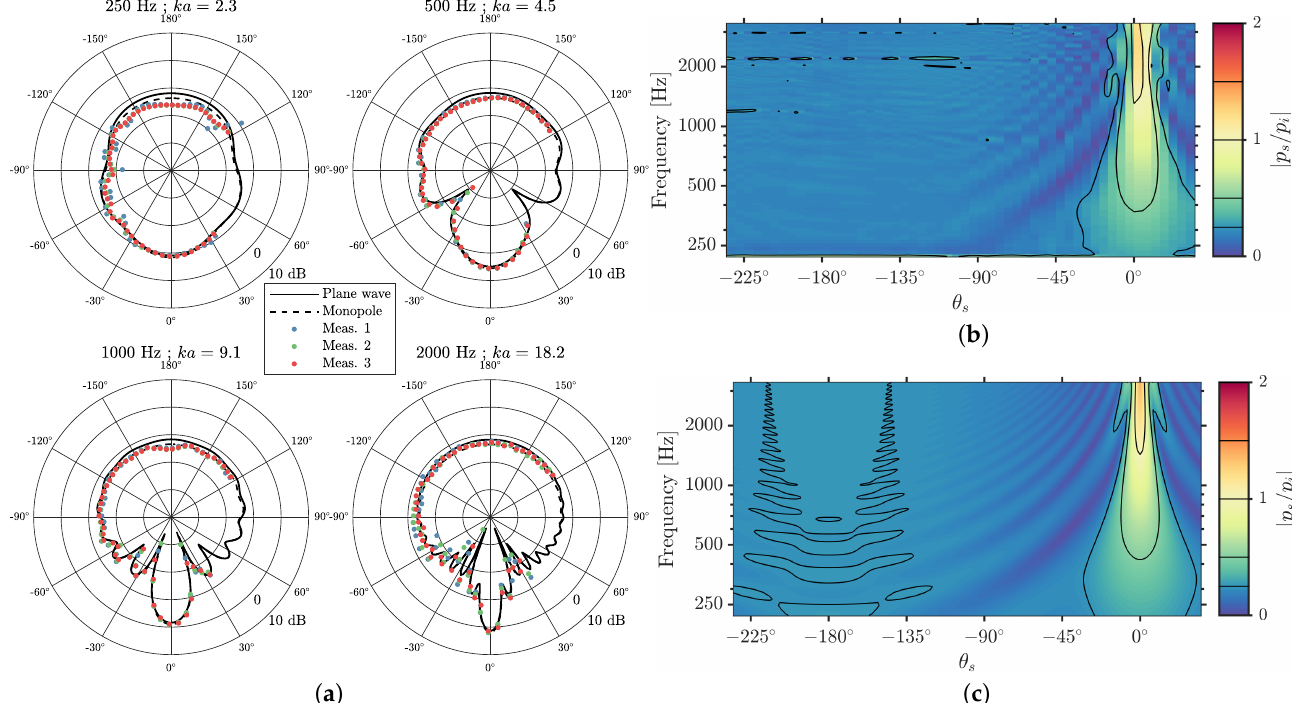
Figure 6. Measured scattered fields (3 repetitions) for a rigid circular cylinder compared to analytic solutions in frequency domain. ( a ) Polar diagrams of relative scattered pressure level, 20log as functions of the scattering angle θ s at different central frequencies of octave bands with the corresponding Helmholtz numbers ka indicated, where k is the wavenumber and a the radius. Magnitude ratio, | p s / p i | , from ( b ) measurements (Meas. 3) with scaled frequency, and ( c ) analytic solutions for plane wave